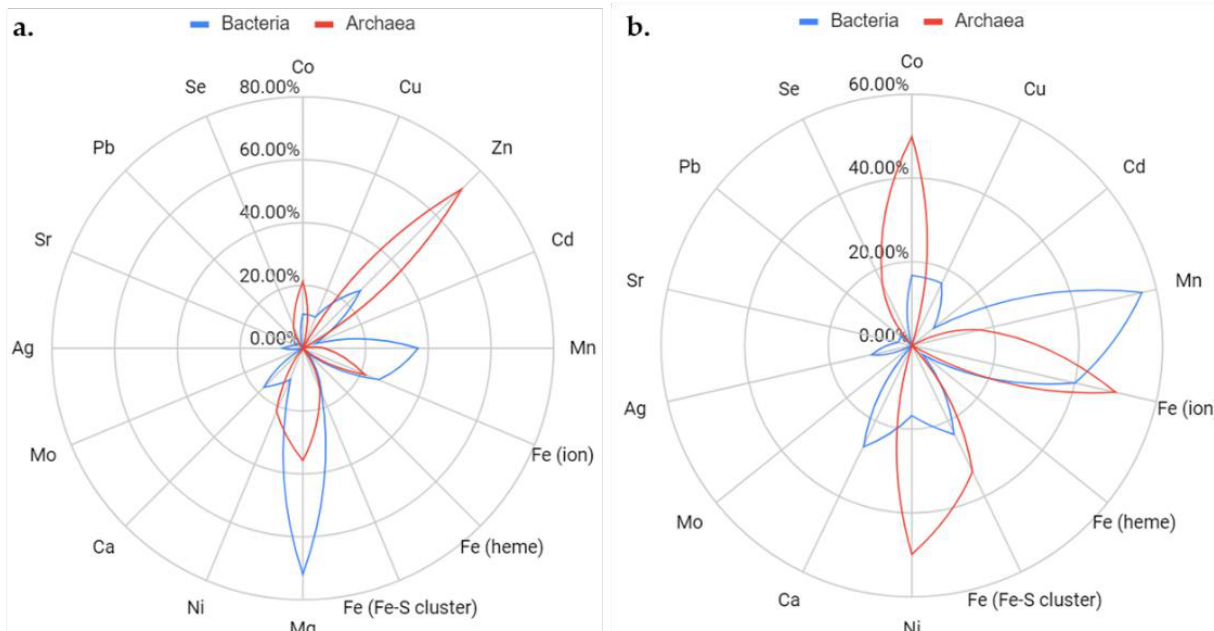
Figure 6. Metal ion-binding of proteins encoded in representative Bacterial and Archaeal operons. ( a ) A radar chart illustrating the proportions of DUF34-operon encoded proteins documented to interact with certain metals or metal-containing moieties. Accounting for the over-representation of magnesium and zinc among available protein structures, a second radar chart ( b ) was generated to show the same data without proteins found to exclusively bind either or both ions. Bacterial data are shown in blue while Archaeal data are shown in red. Data used to generate these figures can be found in Table S4.